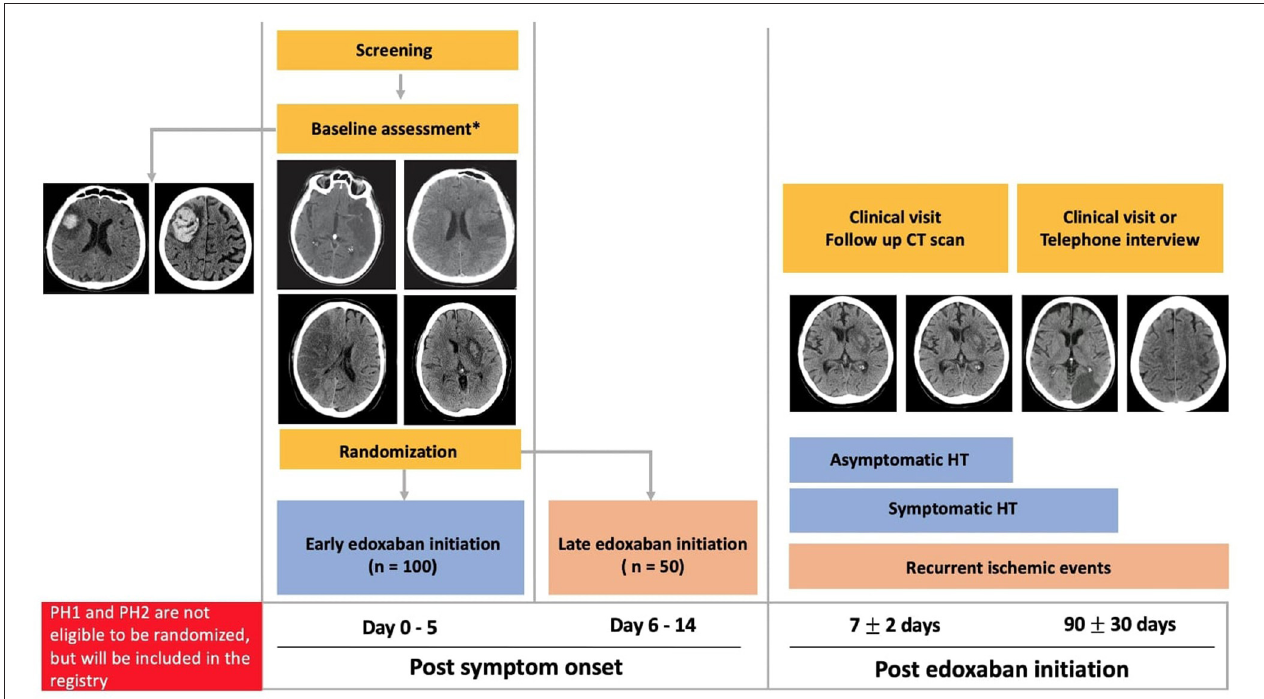
FIGURE 1 | Randomized trial and registry schema. PH, parenchymal hematoma; CT, computed tomography; HT, hemorrhagic transformation. *All stroke severities, infarction sizes and HT (Hemorrhagic infarction type 1 and Hemorrhagic infarction type 2) are eligible for